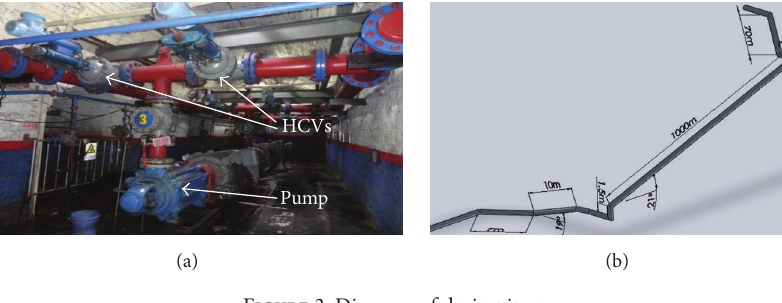
Figure 3: Diagram of drain pipes.